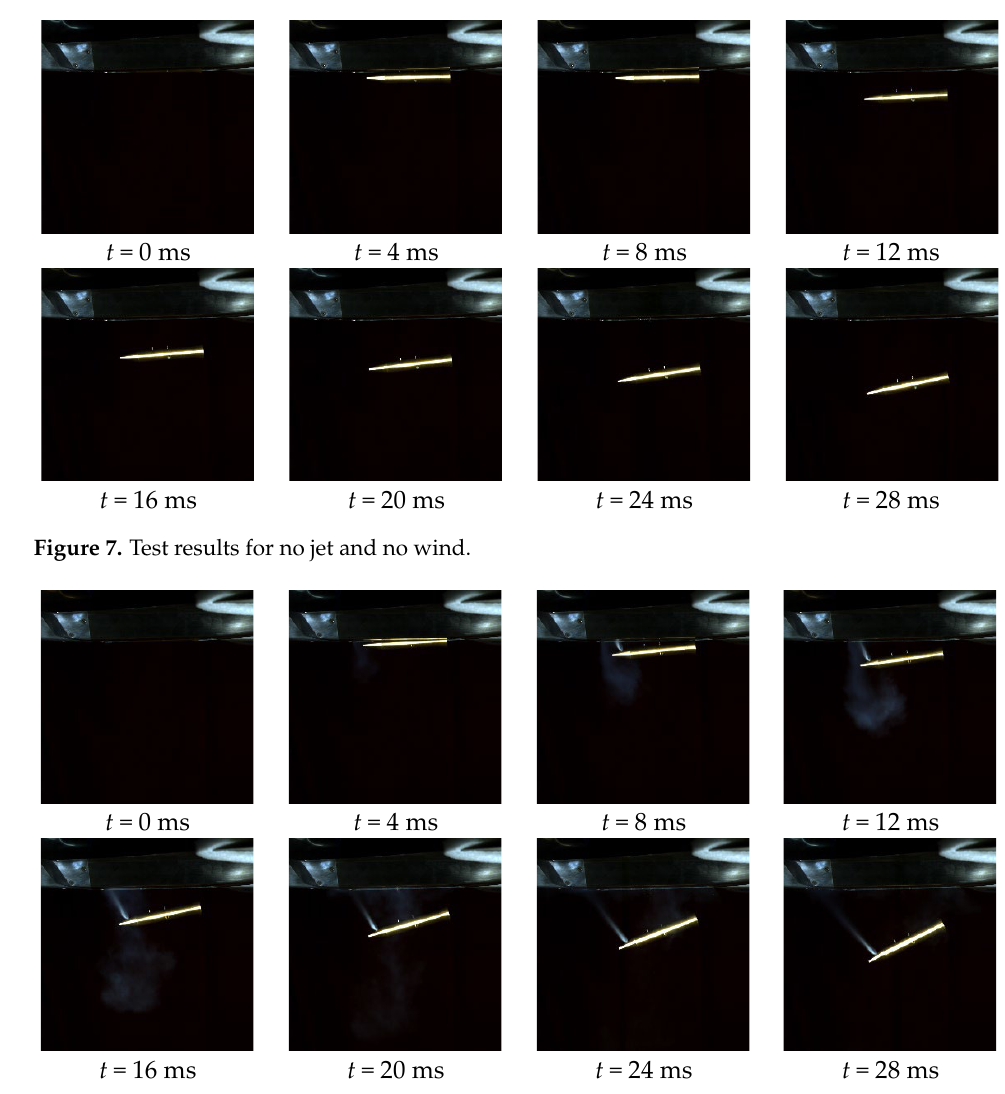
Figure 8. Test results for a 2.0 MPa jet with no wind. In Figure 9, the black curve is without a jet, the blue curve is for a 2.0 MPa jet, and the red curve is for a 4.0 MPa. T he angle of attack of the revolution body is α, which is positive when the revolution body head rises. The values in Figure 9 show that the 2.0 MPa jet makes the revolution body turn over more quickly than when the jet is off. At a 4.0 MPa cylinder pressure, the jet can turn the model over even faster.